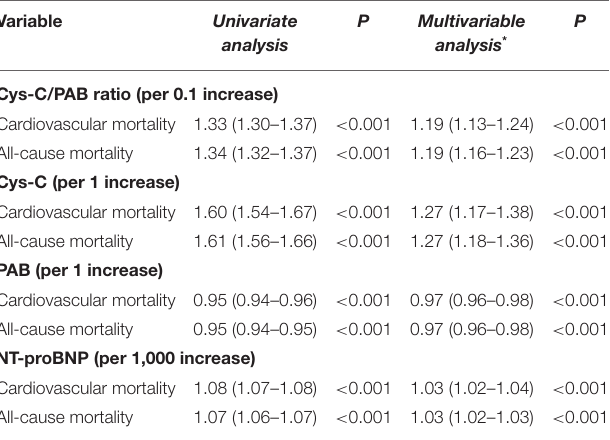
TABLE 2 | The univariate and multivariable Cox regression.